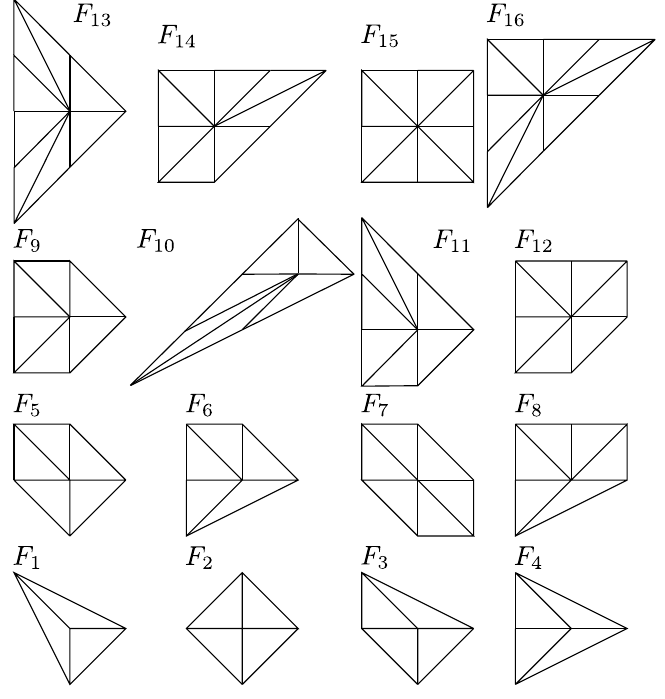
Figure 4 . The 16 two-dimensional re(cid:13)exive polytopes. The image is taken from